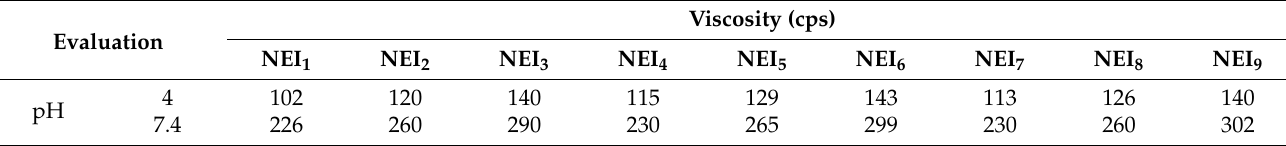
Table 3. Evaluation of viscosity in pH 4 and pH